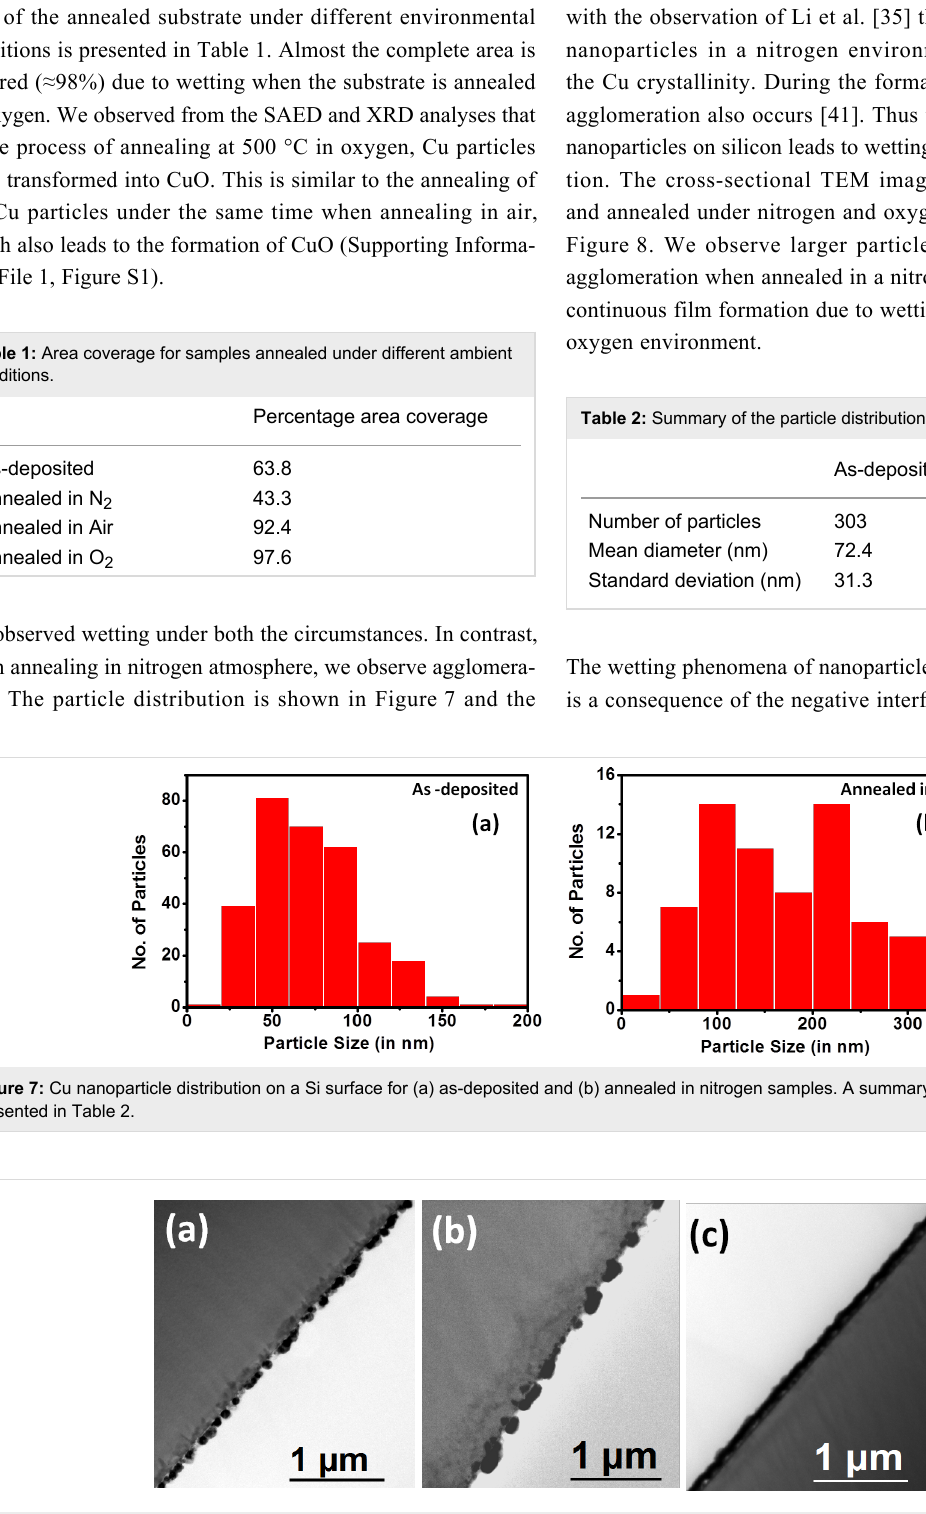
Figure 8: (a) As-deposited Cu nanoparticles on Si and when annealed at 500 °C for 1 min in (b) nitrogen and (c) oxygen.